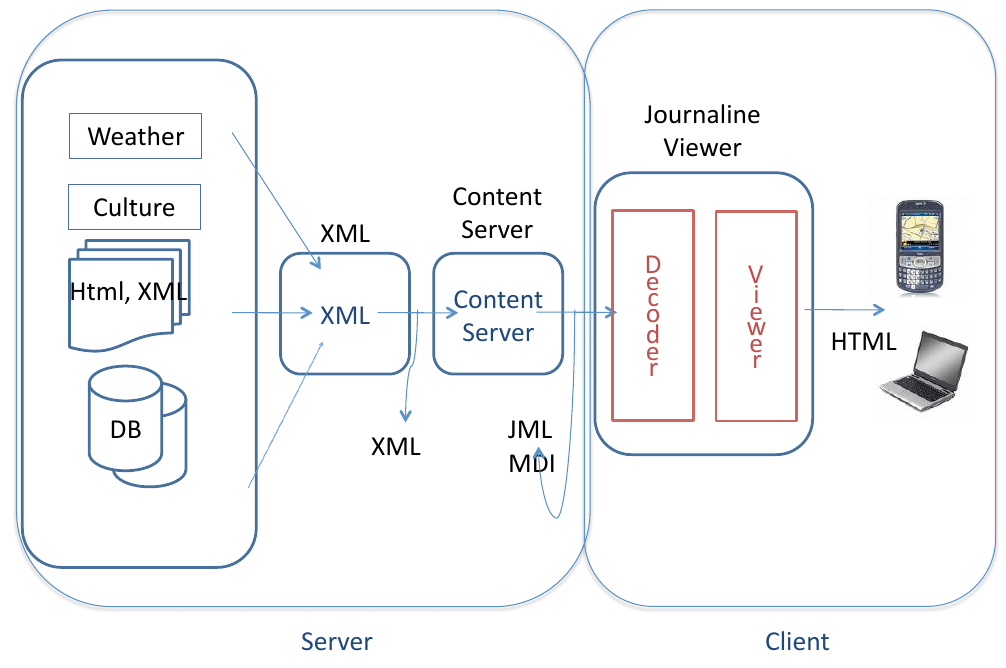
Figure 3. Architecture of Digital